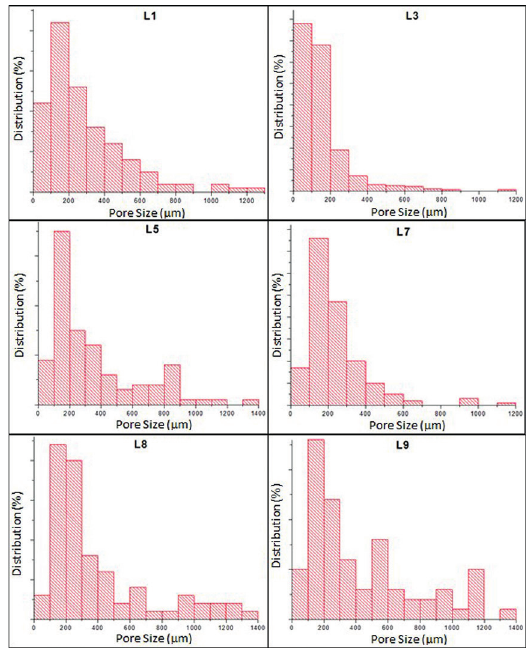
Figure 7: Pore size distribution of the cement